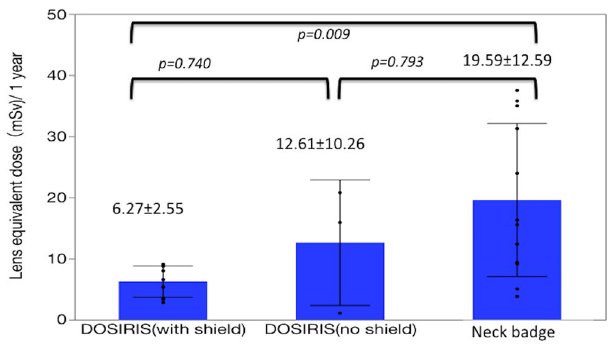
Figure 3. Estimated mean ± SD annual lens dose (EAED) in 12 IC physicians estimated by eye dose (DOSIRIS) measurements (9 physicians used Pb glasses and 3 did not) and neck badge dose